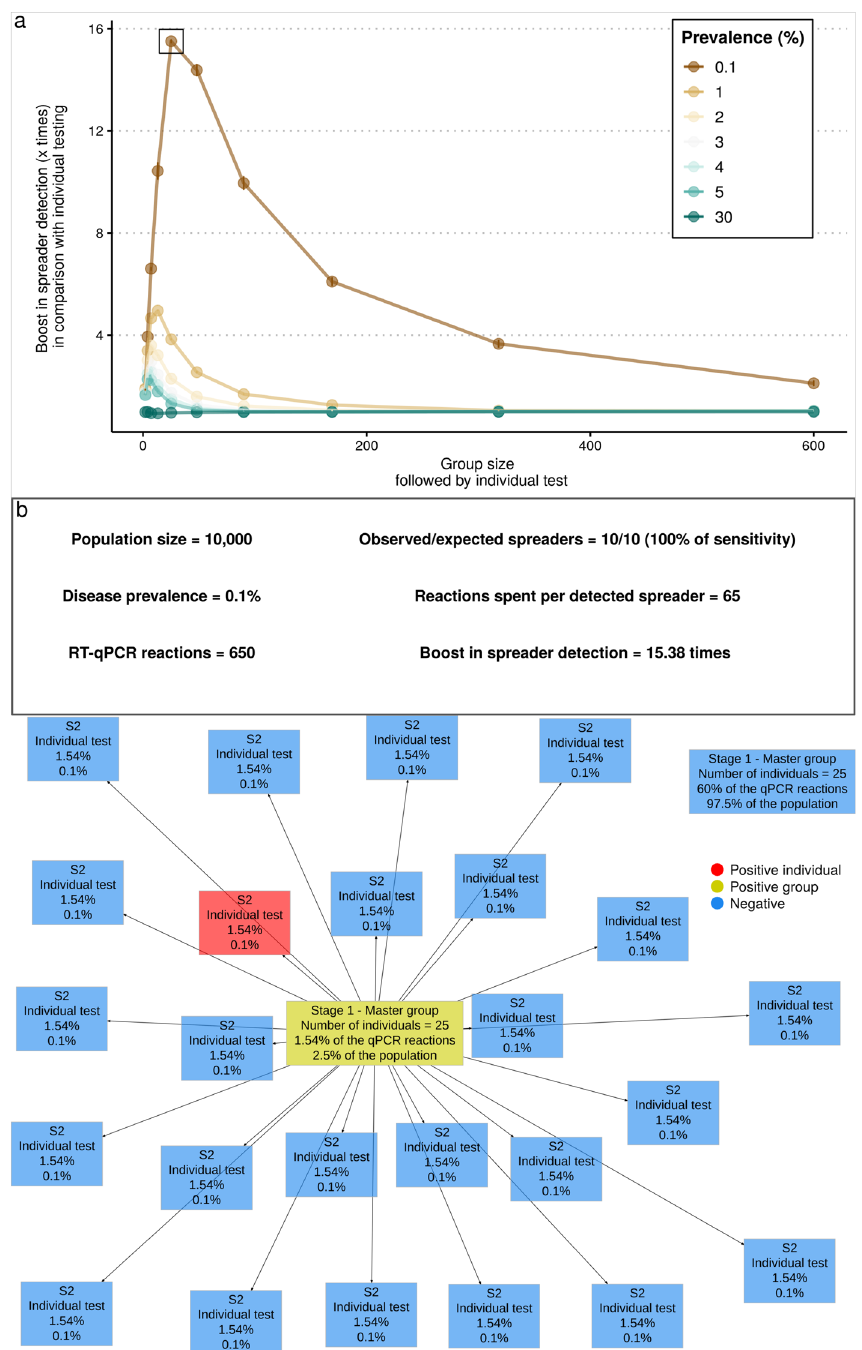
Figure 3. Boost in spreader detection as group size increases in double-stage testing configurations (TCs). Double-stage TCs represent group tests that are followed by an individual test. ( a ) Simulation of ten thousand individuals with disease prevalence ranging from 0.1 to 30% . The x -axis shows all simulated group sizes and the y -axis the boost of the respective TC in the screening power to detect COVID-19 spreaders. The square is around the most efficient simulated TC. ( b ) A diagram of a typical simulated scenario belonging to the double-stage OTC at 0.1% of prevalence. The header gives basic information about the population size used in simulation, prevalence, number of reactions used in total and basic statistics. Each rectangle represents one RT-qPCR reaction, which can be marked as negative group (blue) positive group (yellow) or positive individual (red). The lines connect the reactions that are subsequent performed in this scenario (i.e. stages). All rectangles contain four rows of text, which show from top to bottom: (1) stage of the testing configuration, (2) number of individuals in the group, (3) percent of all reactions that belong to that reaction type (e.g. first group of the second stage that is negative) and (4) percent of the tested population that was submitted to that reaction